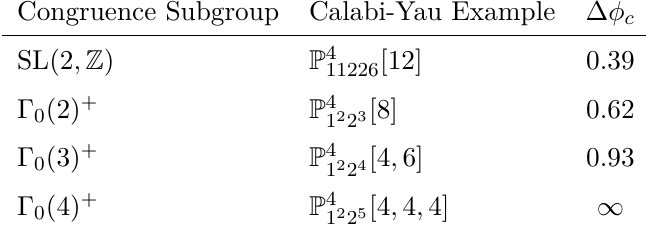
Table 1 . Diameter of the P 1 hybrid phase for Calabi-Yau threefolds fibered by K3 fibers with moduli space H / Γ , where Γ ⊂ SL(2 , R )